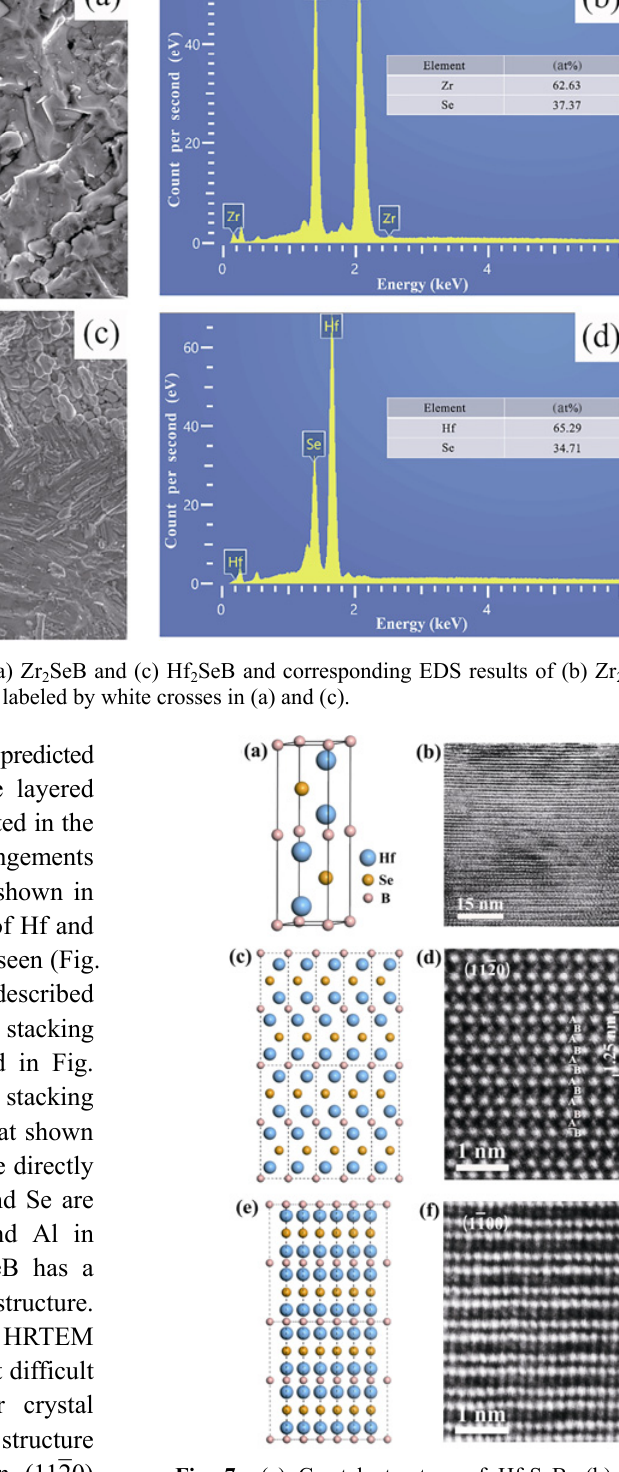
Fig. 7 (a) Crystal structure of Hf 2 SeB, (b) HRTEM image viewed normal to (11¯20) plane of Hf 2 SeB, (c) atomic arrangement on (11¯20) plane of Hf 2 SeB, (d) direct observed atomic stacking sequence by the HRTEM, (e) atomic arrangement on (1¯100) plane of Hf 2 SeB, and (f) direct observed atomic stacking sequence by the